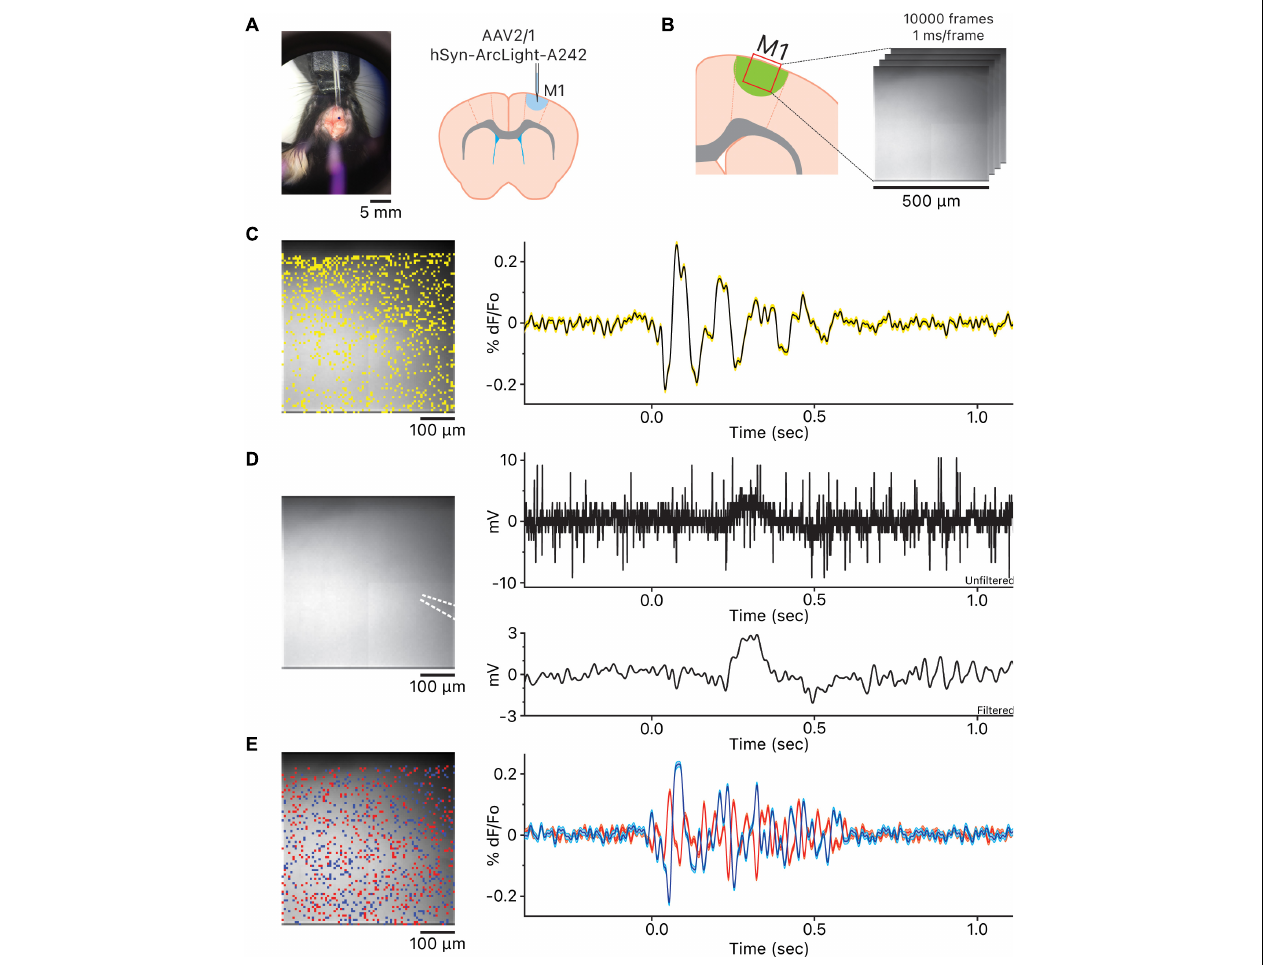
FIGURE 1 | Observation of the oscillations in the motor cortex. (A) View of stereotaxic dissection scope over the area of AAV injection and the injection location in the primary motor cortex. (B) Imaging location in the primary motor cortex. (C) The location of the 1,007 pixels and the representative oscillation waveform produced by averaging the 1,007 oscillation waveforms. Yellow shaded area above and below the representative oscillation waveform indicates ± squared error of the mean. (D) The white dotted lines indicate the location of the local field potential (LFP) recording glass micropipette. To the right are the unfiltered LFP recording and the LFP recording 5–50 Hz bandpass filtered using the 5th order Butterworth high-pass and low-pass filters. Both unfiltered and filtered LFP recordings are time aligned to the representative oscillation waveform shown in panel (C) . (E) Heterogeneity of oscillation waveforms in each recording. The blue pixels are the pixels whose oscillation waveforms are the most positively correlated to the reference pixel; blue oscillation waveform is the averaged waveform, and cyan shaded area above and below the averaged waveform indicates ± squared error of the mean. The red pixels are the most negatively correlated to the reference pixel; red oscillation waveform is the averaged waveform, and pink shaded area above and below the averaged waveform indicates ± squared error of the mean. The blue and red oscillation waveforms are time aligned to both the representative oscillation waveform in C and the LFP recordings in panel (D)